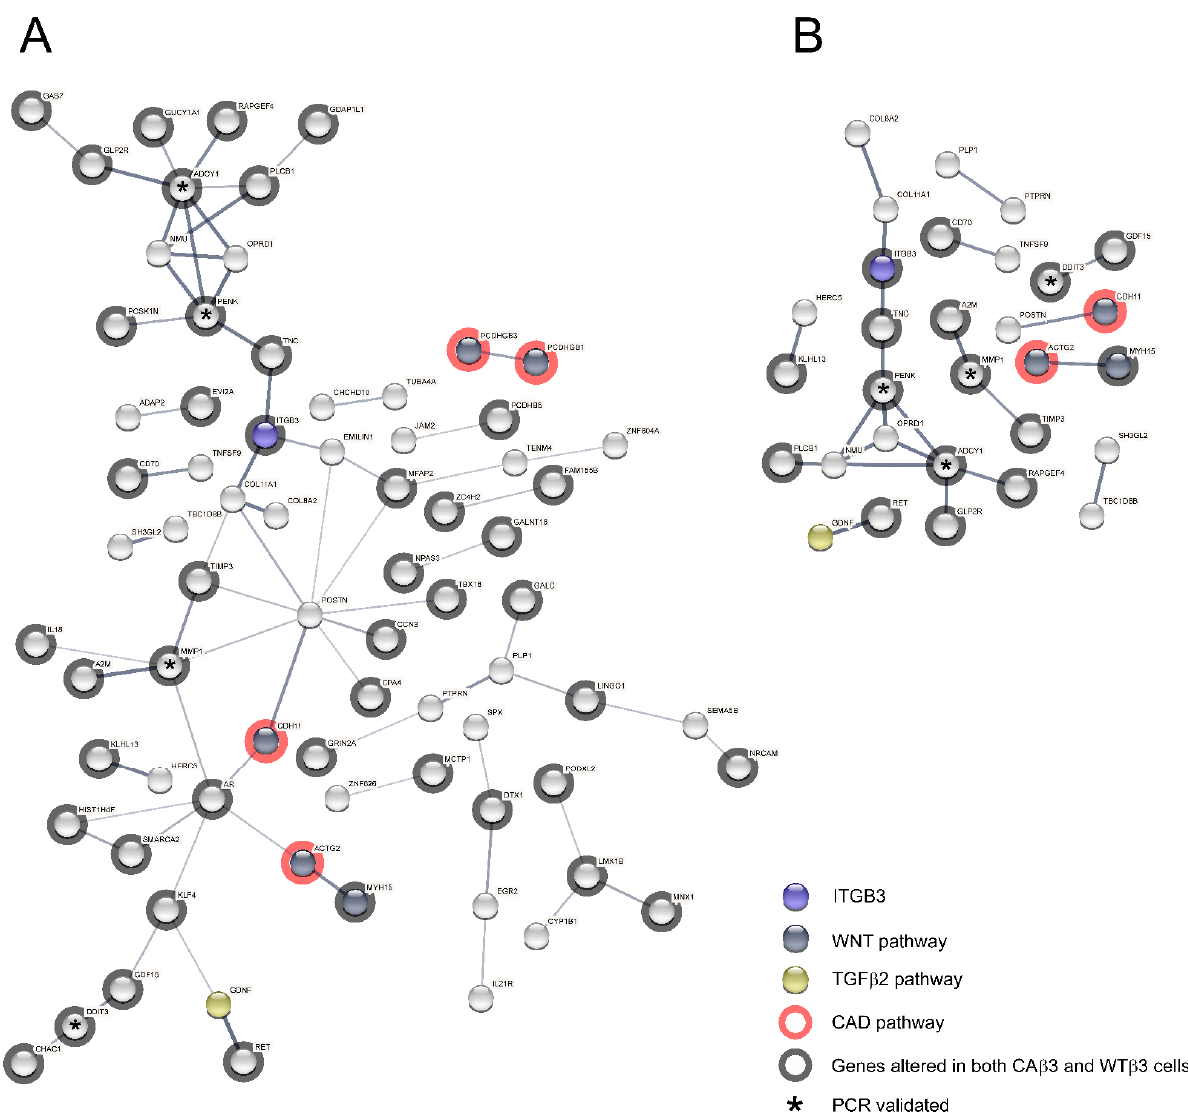
Figure 12. WT β 3 protein-protein interaction (PPI) networks are similar to those of a random collection of proteins. Differentially expressed genes resulting from overexpression of a WT- α v β 3 integrin were entered into the STRING database. The networks display the proteins encoded by each input gene. The input consisted of uniquely altered genes as well as altered genes that were shared with cells overexpressing a CA- α v β 3 integrin. ( A ) Network calculated using a medium (0.4) statistical confidence; PPI enrichment p -value = 0.143. (Interactive link for Figure 12A: permanent link: https://version-11-0b.string-db.org/cgi/network?networkId=bEnUFrdwbGJv) (accessed on 20 June 2021) ( B ) Network calculated using a high (0.7) statistical confidence; PPI enrichment p -value = 0.259. (Interactive link for Figure 12B: permanent link: https://version-11-0b.string-db.org/cgi/network?networkId=b9wf05GlAE9T) (accessed on 20 June 2021). The confidence score is the approximate probability that a predicted link exists between two proteins in the same metabolic map in the KEGG database. Both PPI enrichment scores indicate that the calculated networks are not significantly different from networks generated by a random collection of input genes at the same confidence level. For both networks, the proteins for which there were no connections to be mapped were not displayed. The location of β 3 integrin (INTB3), members of the TGF β 2, Wnt and Cadherin signaling pathways as well as those gene products that are also differentially expressed in CA β 3 cells are all indicated. * Genes that were validated by RT-qPCR.